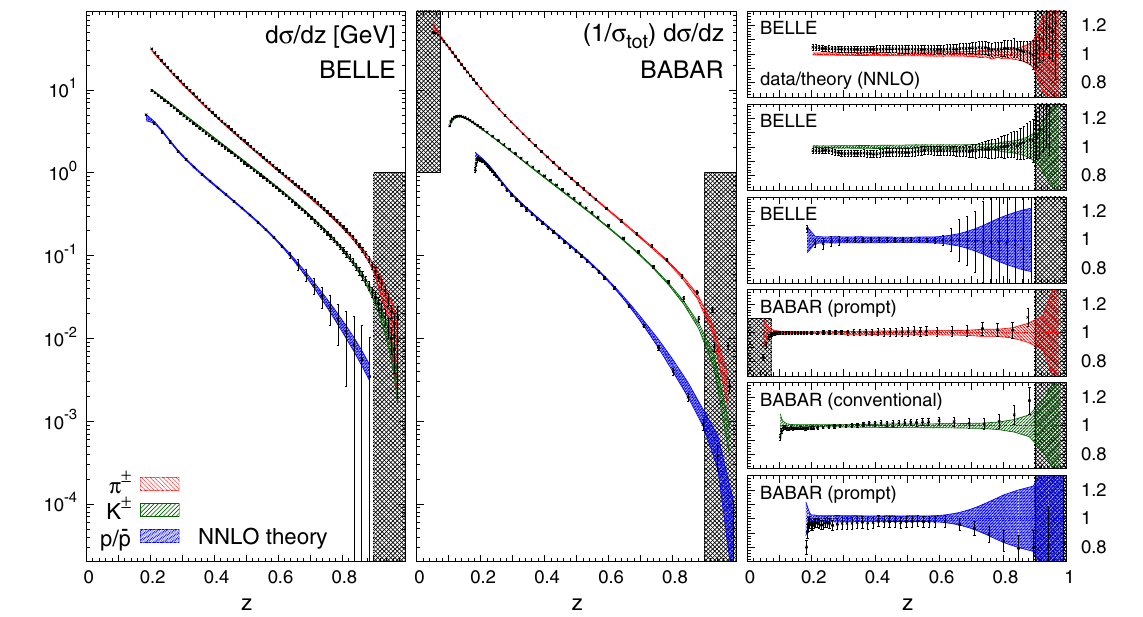
Fig. 4 Comparison between the dataset for charged pions, charged kaons, and protons/antiprotons from the BELLE and BABAR experi- ments and the corresponding NNLO theoretical predictions using our best-fit NNLO FFs. We show both the absolute distributions ( left and